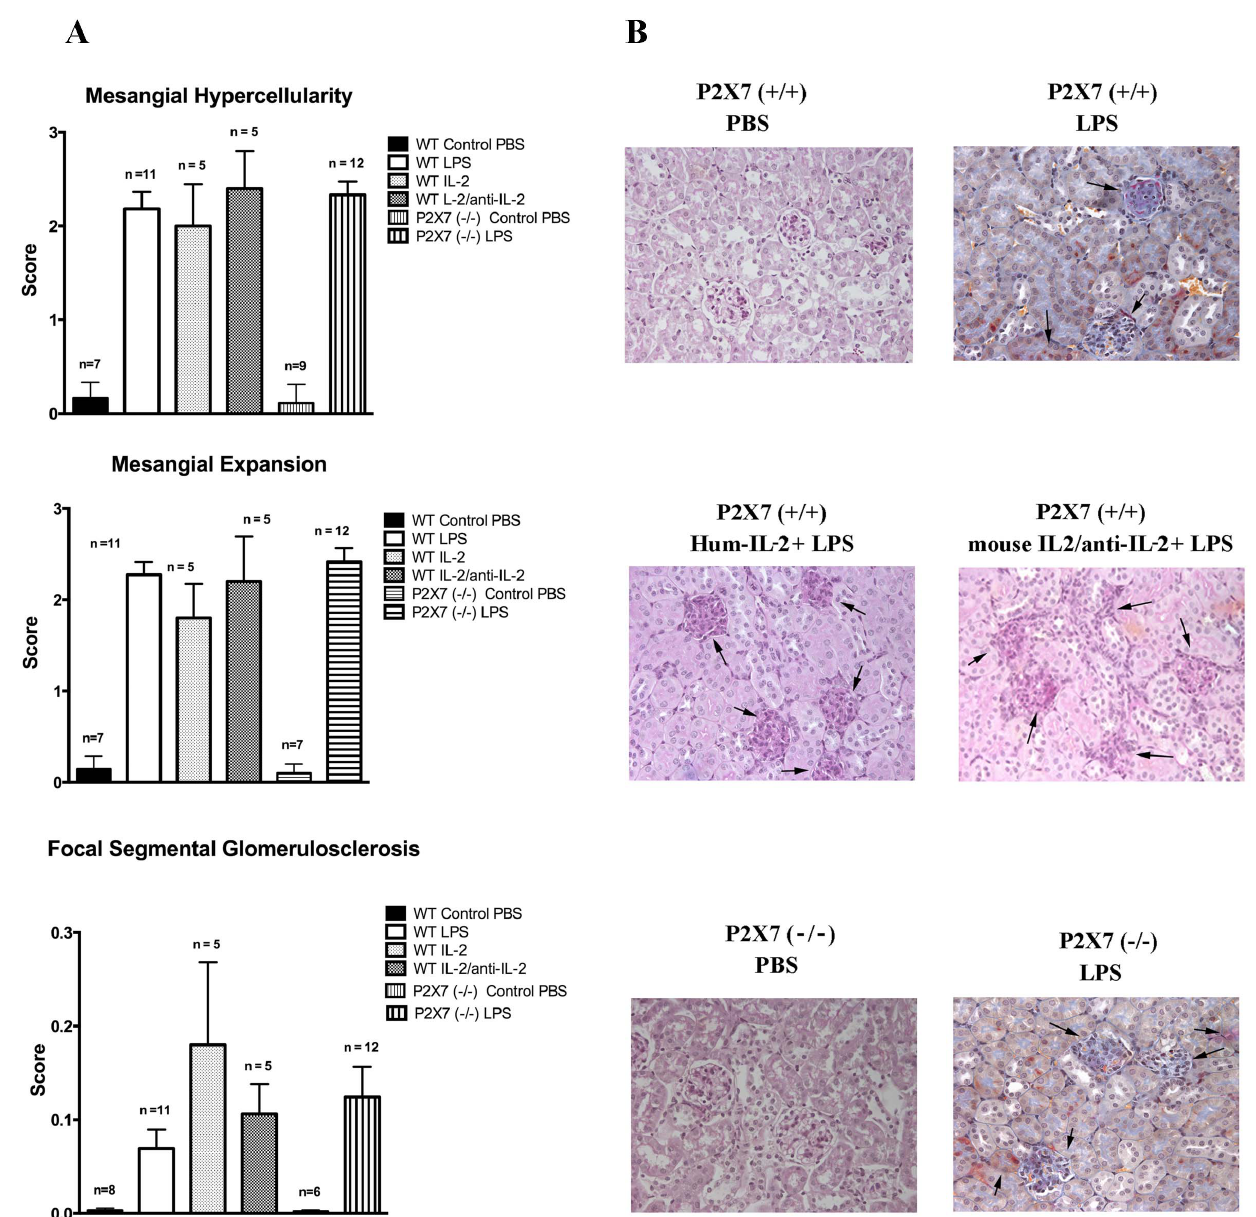
Figure 2. Histology features. Classical histology (Ematoxylin Eosin, PAS) of kidney biopsies was evaluated after several times from LPS infusion (24hrs, 72 hrs and 7 days). Three main features were observed: 1-mesangial hypercellularity, 2-mesangial expansion and 3-focal segmental glomerulosclerosis that were determined in a semi-quantitative basis (score 0–3 for the former two parameters, score 0–0.3 for glomerulosclerosis). Relevant results observed after 7 days are presented in this figure (A). Specific patterns are shown in (B); stains are hematoxylin eosin for all with the exception of Masson Blue stain for LPS alone.